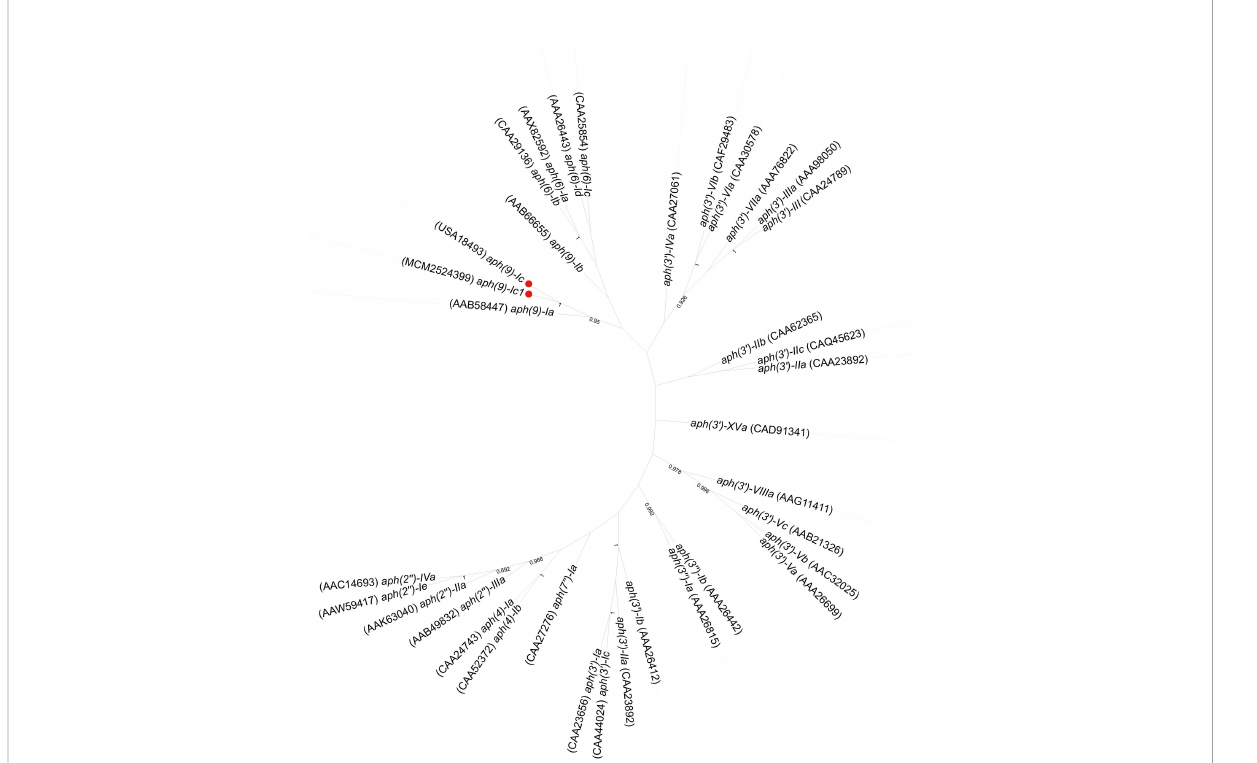
FIGURE 3 Phylogenetic tree showing the relationship of the APH(9)-Ic and APH(9)-Ic1 proteins with the other function-characterized APH genes. The proteins from this study are shown with a red dot.